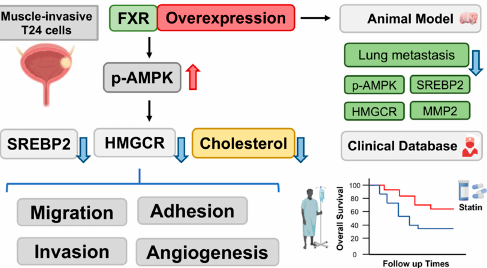
Figure 9. Scheme of FXR overexpression effects in vitro, in vivo and statin usage with BLCA patients in clinical database.